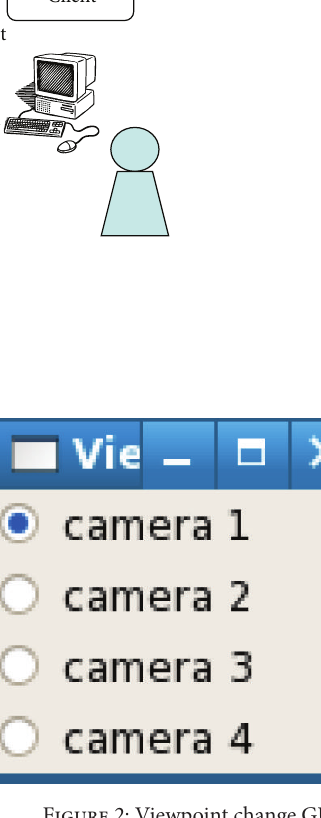
Figure 2: Viewpoint change